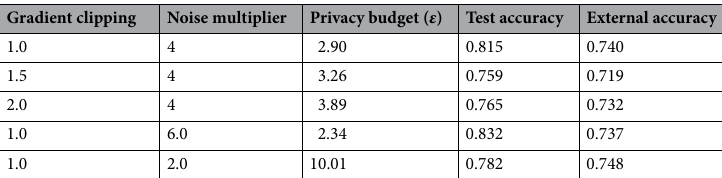
Table 3. Ablation study of DP hyperparameters (gradient clipping and noise multiplier).